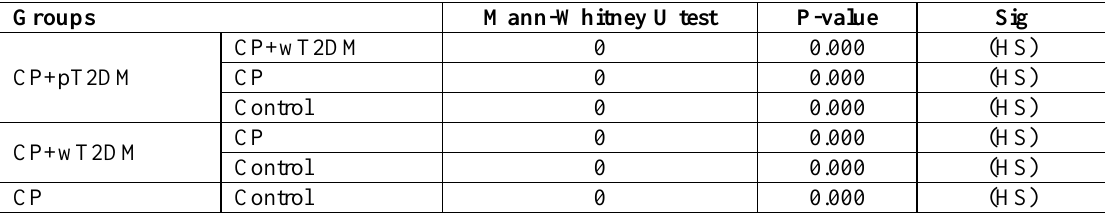
Figure 1: Bar chart for median values of Osteocalcin concentrations (ng/ml) for the study and control groups Table 4: Comparison between each two groups of Osteocalcin concentrations (ng/ml) for the study and control